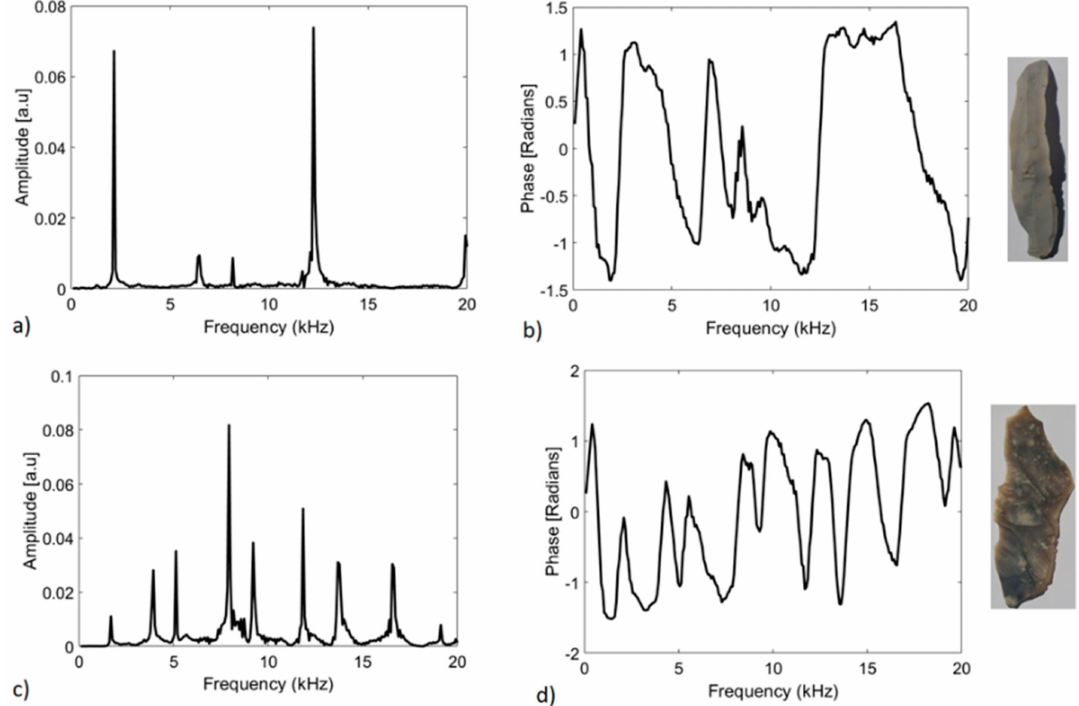
Figure 6. Spectrum results for the flint blades tested. ( a ) Magnitude for Sample 1; ( b ) Phase for Sample 1; ( c ) Magnitude for Sample 2; ( d ) Phase for Sample 2. Photo & graphics: Tayong